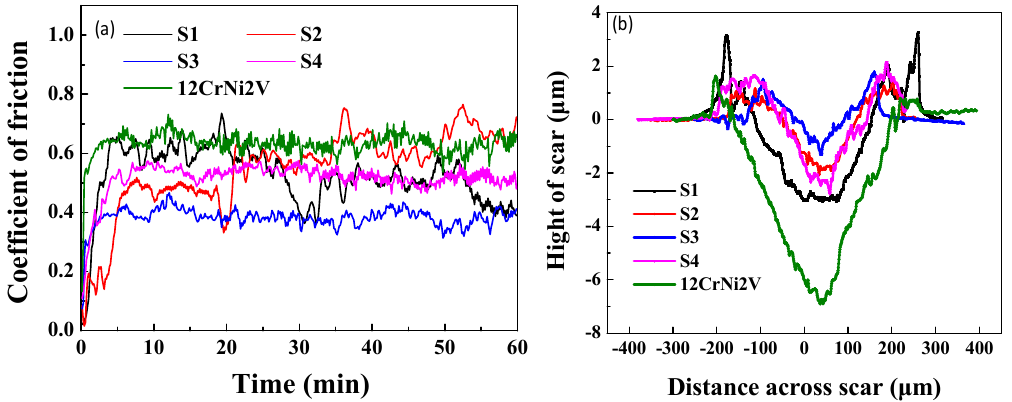
Figure 10. The friction coefficient curves of Fe-based alloy gradient materials ( a ) and typical cross-sectional profiles of the wear tracks ( b ).